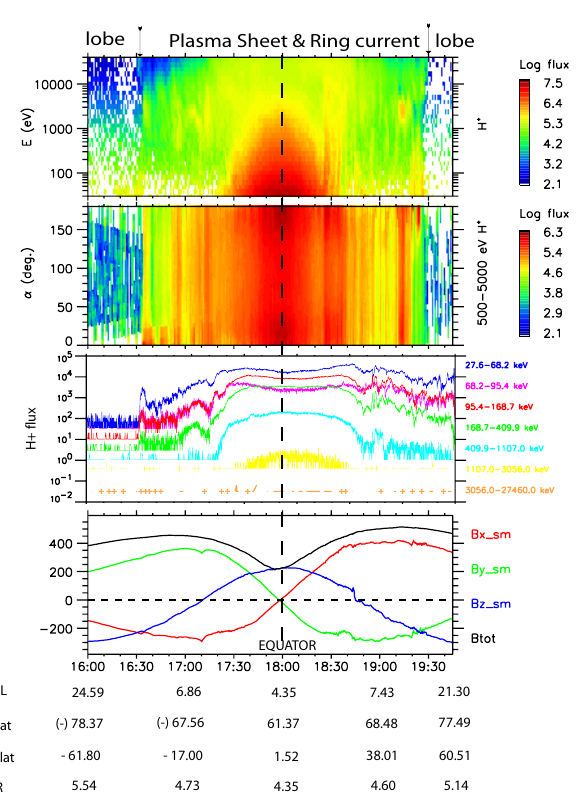
Fig. 13. Cluster SC4 data for the 20 April 2002 event: H + energy-time spectrogram in particle flux units (ions/cm 2 srskeV), the pitch-angle distribution (in particle flux units) for the 0.5 to 5keV energy range, the H+ energy-time spectrogram from the RAPID instrument (27.6–3056.0keV), and the magnetic field com- ponents in the SM coordinate system. L-shell, invariant latitudes, magnetic latitudes and geocentric distances are indicated below. Dashed line represents the equatorial